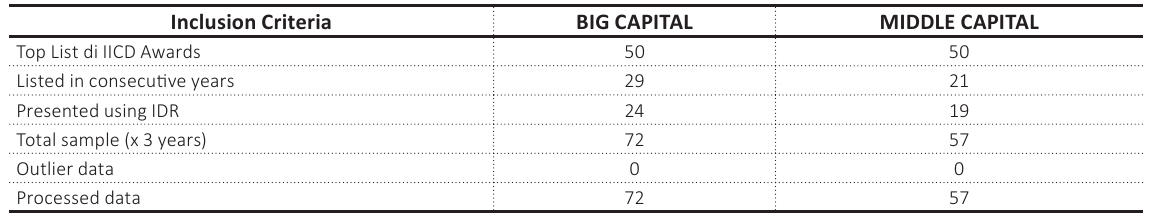
Table 2. Dependent, independent, and control variables